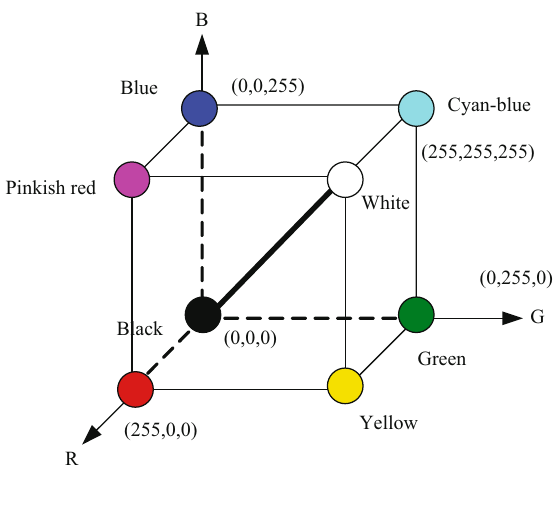
Figure 3: RGB color